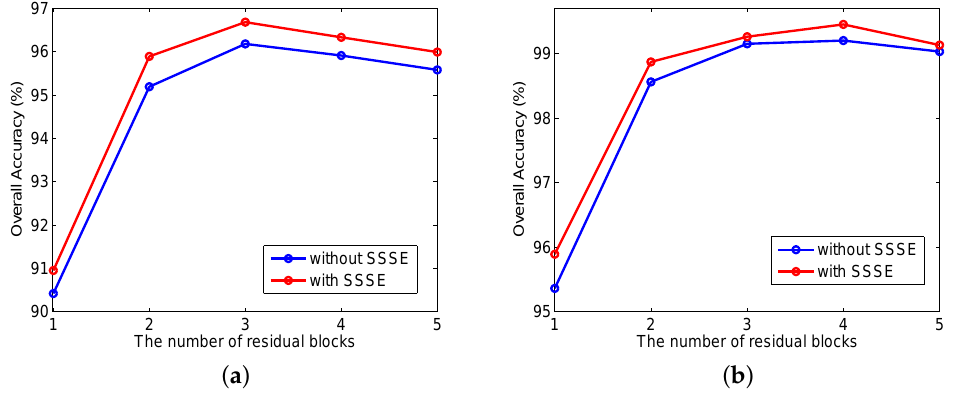
Figure 11. OA versus the number of SSSE residual modules: ( a ) 5% training samples; and ( b ) 15% training